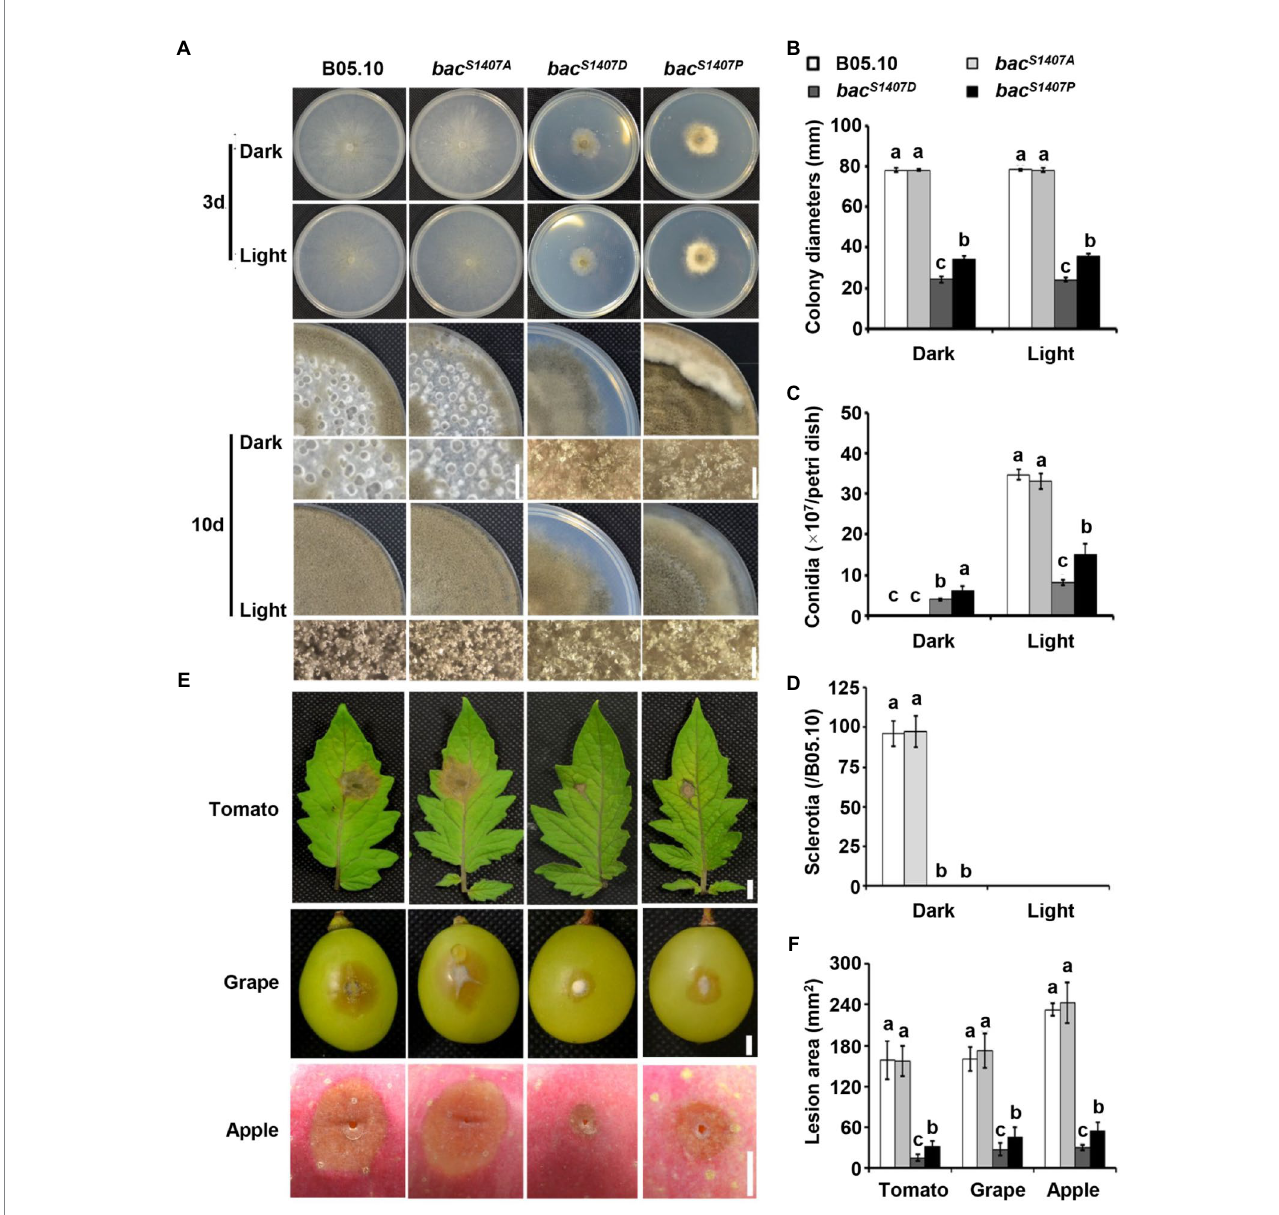
FIGURE 4 Growth and pathogenic phenotype analysis of different strains. (A) Wild-type (B05.10) and mutant strains ( bac S1407P , bac S1407A , bac S1407D , and bac P1407S ) were incubated onto solid CM medium for 3 or 10 days under continuous white light (LL) and dark (DD) conditions. (B–D) Statistical analyses of the colony diameters, conidia, and sclerotia of (A) . (E) Wild-type (B05.10) and mutant strains ( bac S1407P , bac S1407A , bac S1407D , and bac P1407S ) were incubated onto grape (72 h), tomato leaf (48 h), and apple surfaces (96 h). (F) Statistical analysis of the lesion area of (E) . Different letters indicate significant differences at p < 0.01. The bars present mean values ± SD ( n =